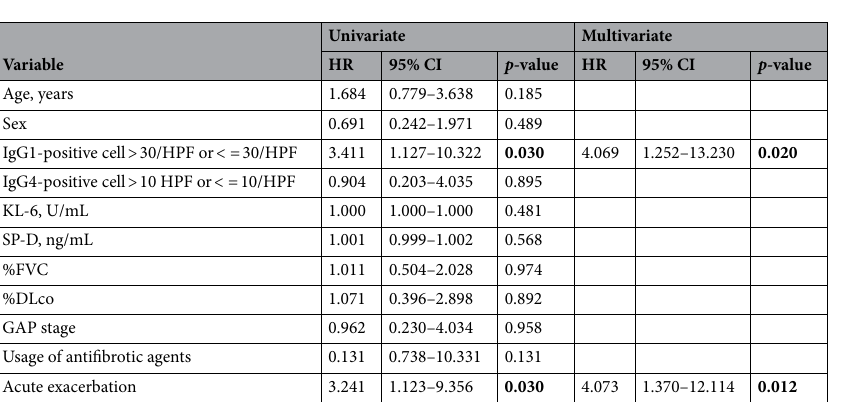
Univariate Multivariate HR 95%